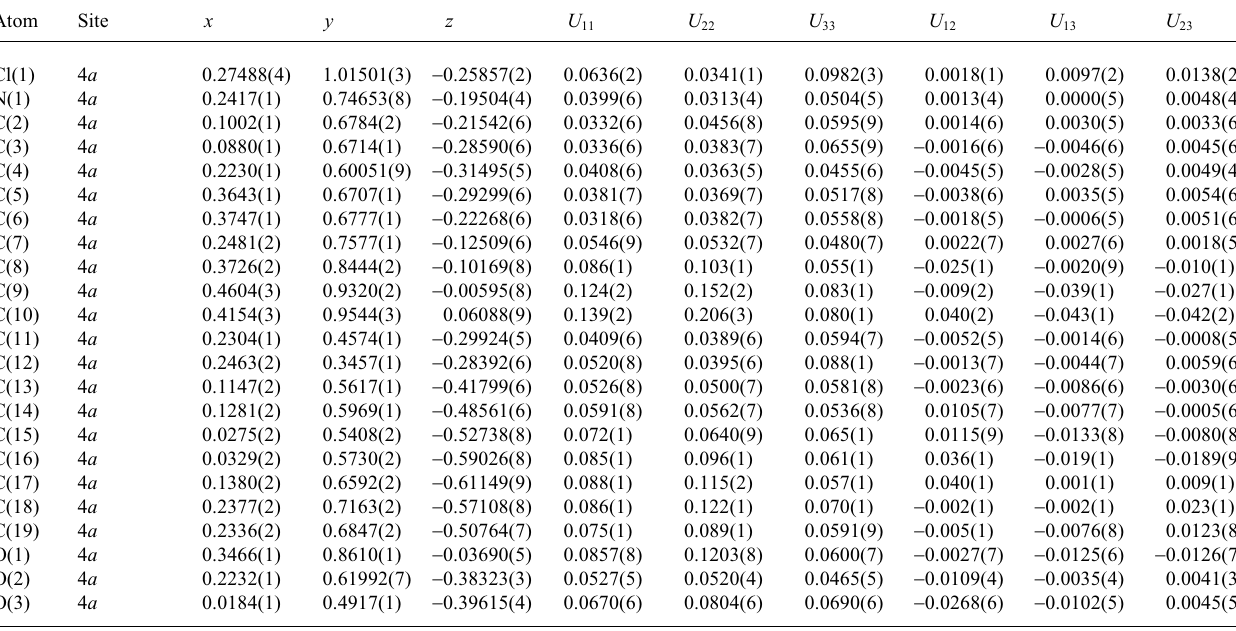
Table 3. Atomic coordinates and displacement parameters (in Å 2